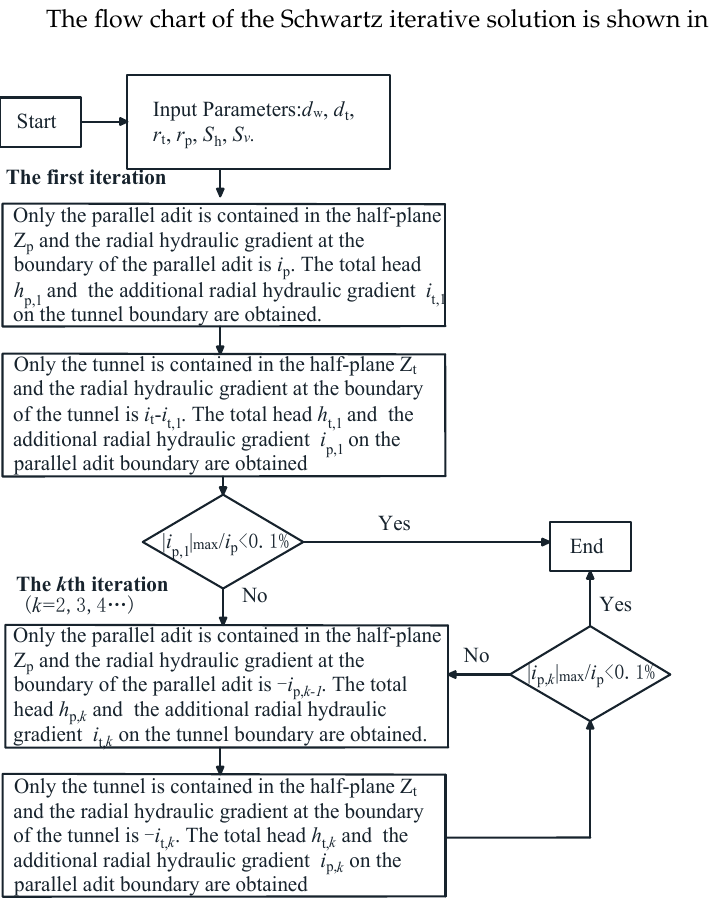
Figure 4. Flow chart of the Schwartz iterative method.